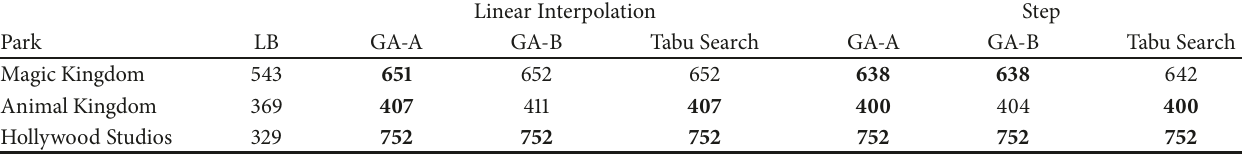
Table 5: Results for Disney